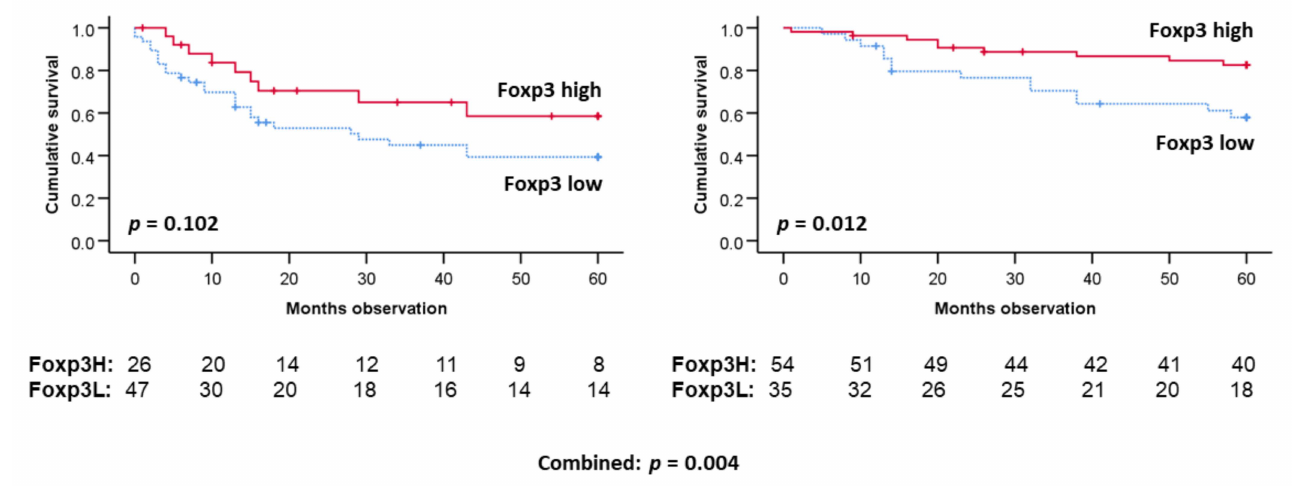
Figure 5. Five-year DSS TIL Foxp3 (+) levels by tumor HPV status. HPV determined by PCR. p16 determined by immunohistochemistry. Two bottom lines on each figure: Number of patients at risk. Survival curves and statistics by Kaplan–Meier plot with Log rank p